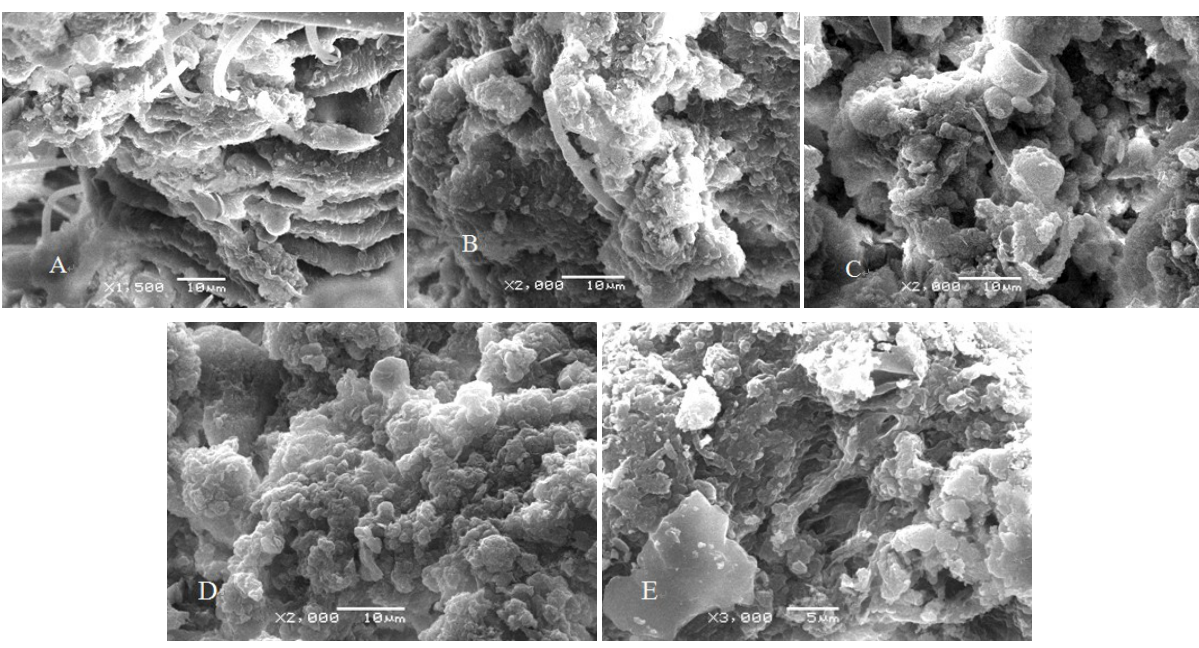
Figure 6. Scanning electron microscopy (SEMs) illustrating the different types of bacteria in the granular sludge from Compartments 1 to 5, respectively. (A) Compartment